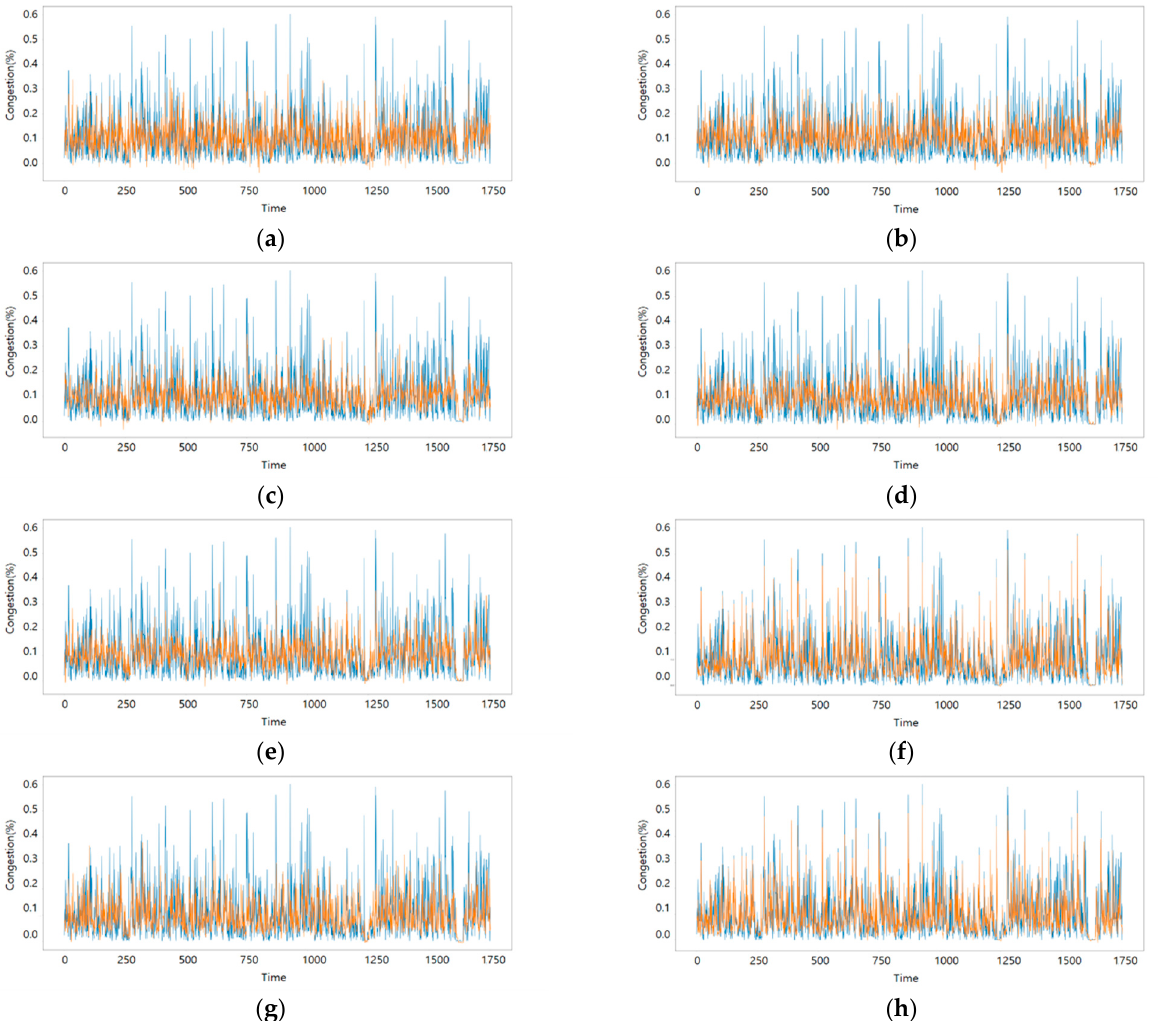
Figure 7. Model training results under each scenario: ( a ) Scenario with input data as Congestion; ( b ) Scenario with input data as Congestion, Variance width/rate/Prob.; ( c ) Scenario with input data as Congestion, 3, 6, 12, 24 avg.; ( d ) Scenario with input data as Congestion, 3, 6, 12, 24 max.; ( e ) Scenario with input data as Congestion, Num of ship, Traffic Vol.; ( f ) Scenario with input data as Congestion, Variance width/rate/Prob., 3, 6, 12, 24 avg., 3, 6, 12, 24 max., Num of ship, Traffic Vol.; ( g ) Scenario with input data as Congestion(B Gate), Congestion(C Gate); ( h ) Scenario with input data as Conges ‐ tion, Variance width/rate/Prob., 3, 6, 12, 24 avg., 3, 6, 12, 24 max., Num of ship, Traffic Vol., Conges ‐ tion(B Gate), Congestion(C Gate). The sky blue line represents actual data and orange line represents predicted data.